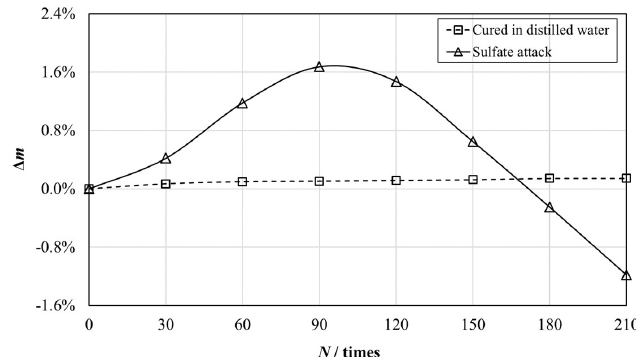
Figure 9. The evolution of mass of structural EPS concretes of group B and C with different numbers of W–D cycles ( N ).